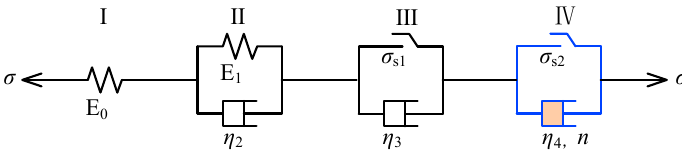
Figure 2. Improved Nishihara model.